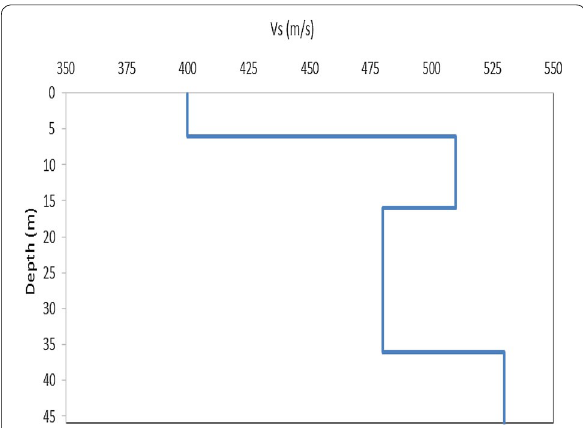
Fig. 8 Shear wave velocity profile at Mansadevi landslide, Haridwar